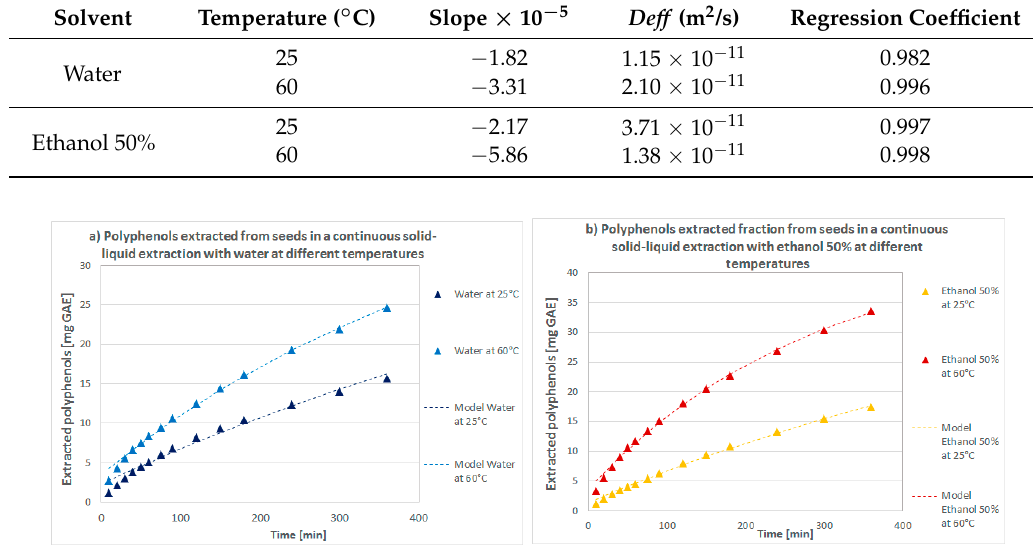
Figure 4. Total polyphenols extracted from Sterculia apetala seeds in a solid-liquid continuous extraction in ( a ) water and ( b ) ethanol 50% at 25 °C and 60 °C.